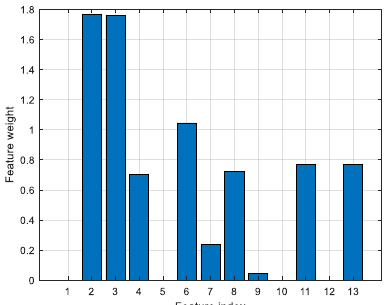
Figure 2. The feature weights calculated by Neighborhood Components Analysis (NCA).